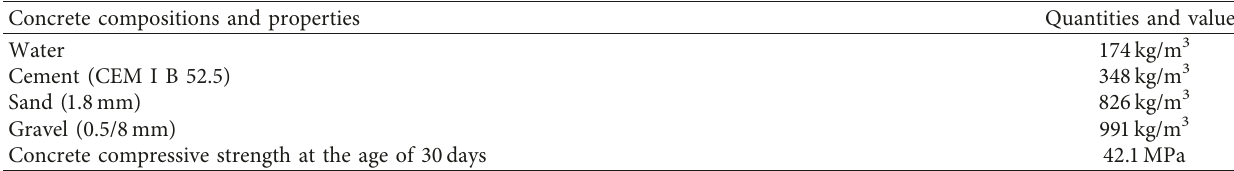
Table 1: Properties and quantities of concrete compositions.